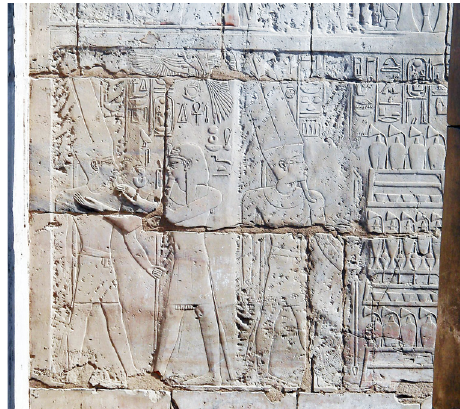
Fig. 5: Temple relief in Luxor. King Amenho- tep III makes offerings to the god Amun and receives the regalia of kingship. (Photo: R. Bussmann).